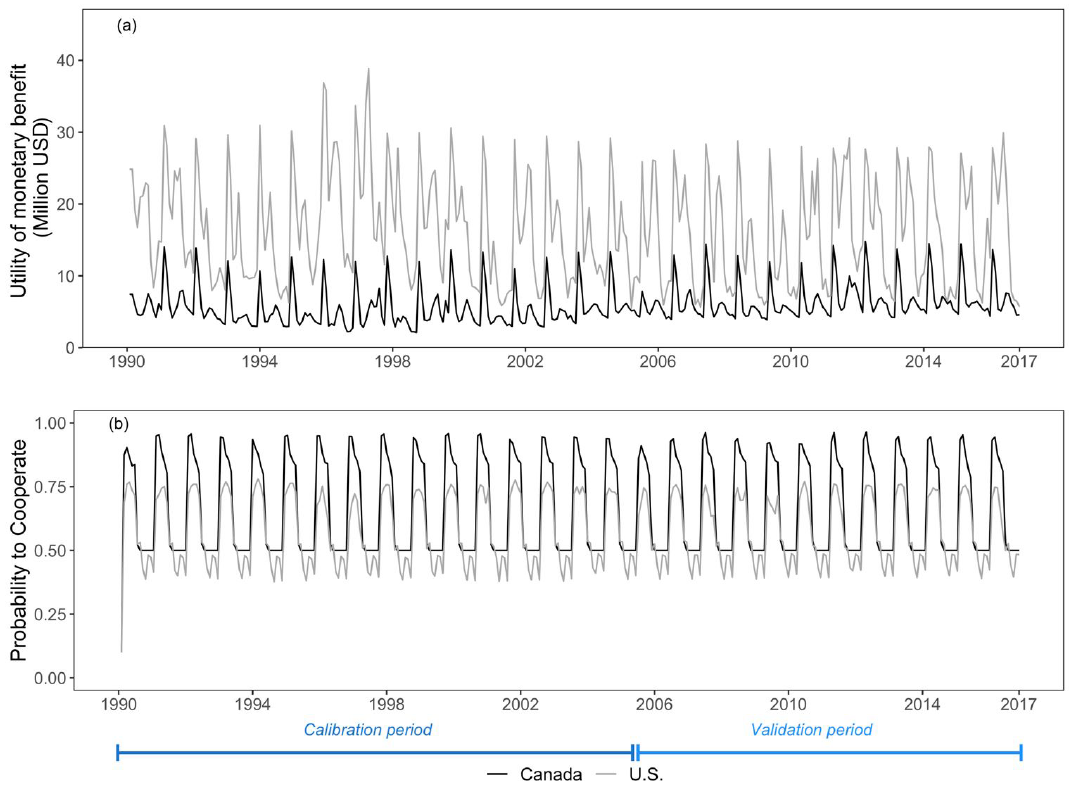
Figure 7. Change in (a) the utility of monetary benefit and (b) probability to cooperate during calibration and validation period for Canada and the United States. Note that the lower initial probability to cooperate during 1990 is only due to the warmup period of model